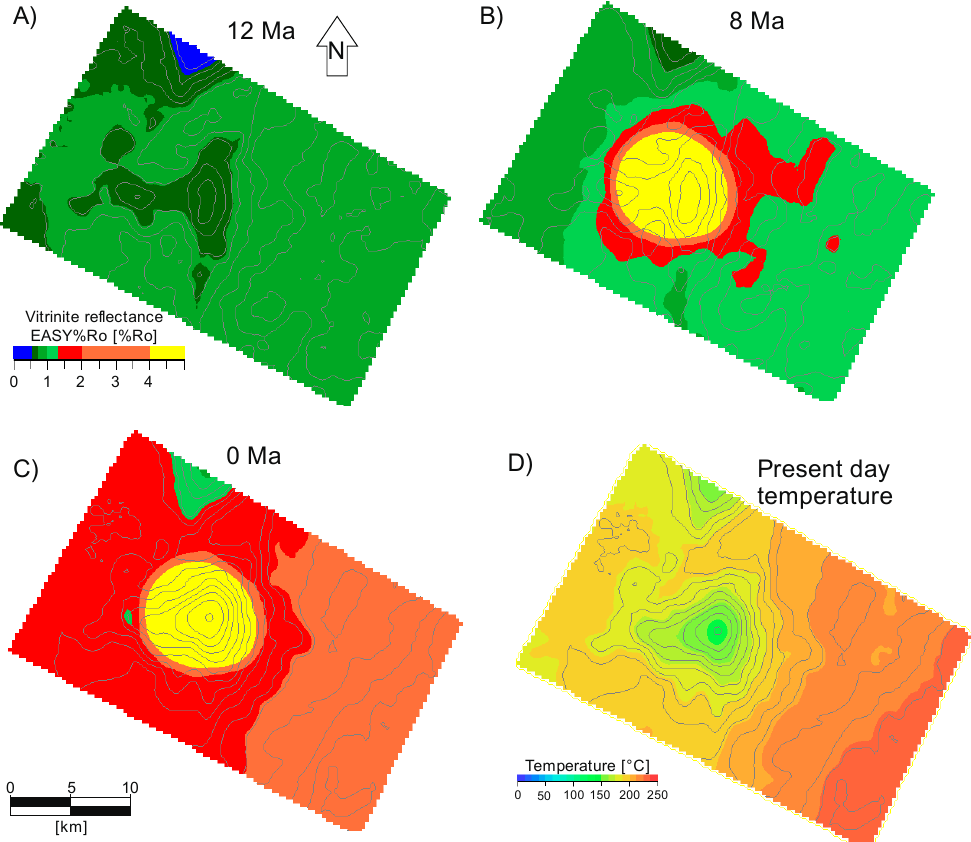
Figure 16. ( A )–( C ) Maturity change at the unit of Waipawa Formation before and after intrusion. Figure 16. A – C Maturity change at the unit of Waipawa Formation before and after intrusion. D – ( D )–Present day temperature at Waipawa Present day temperature at Waipawa Formation.